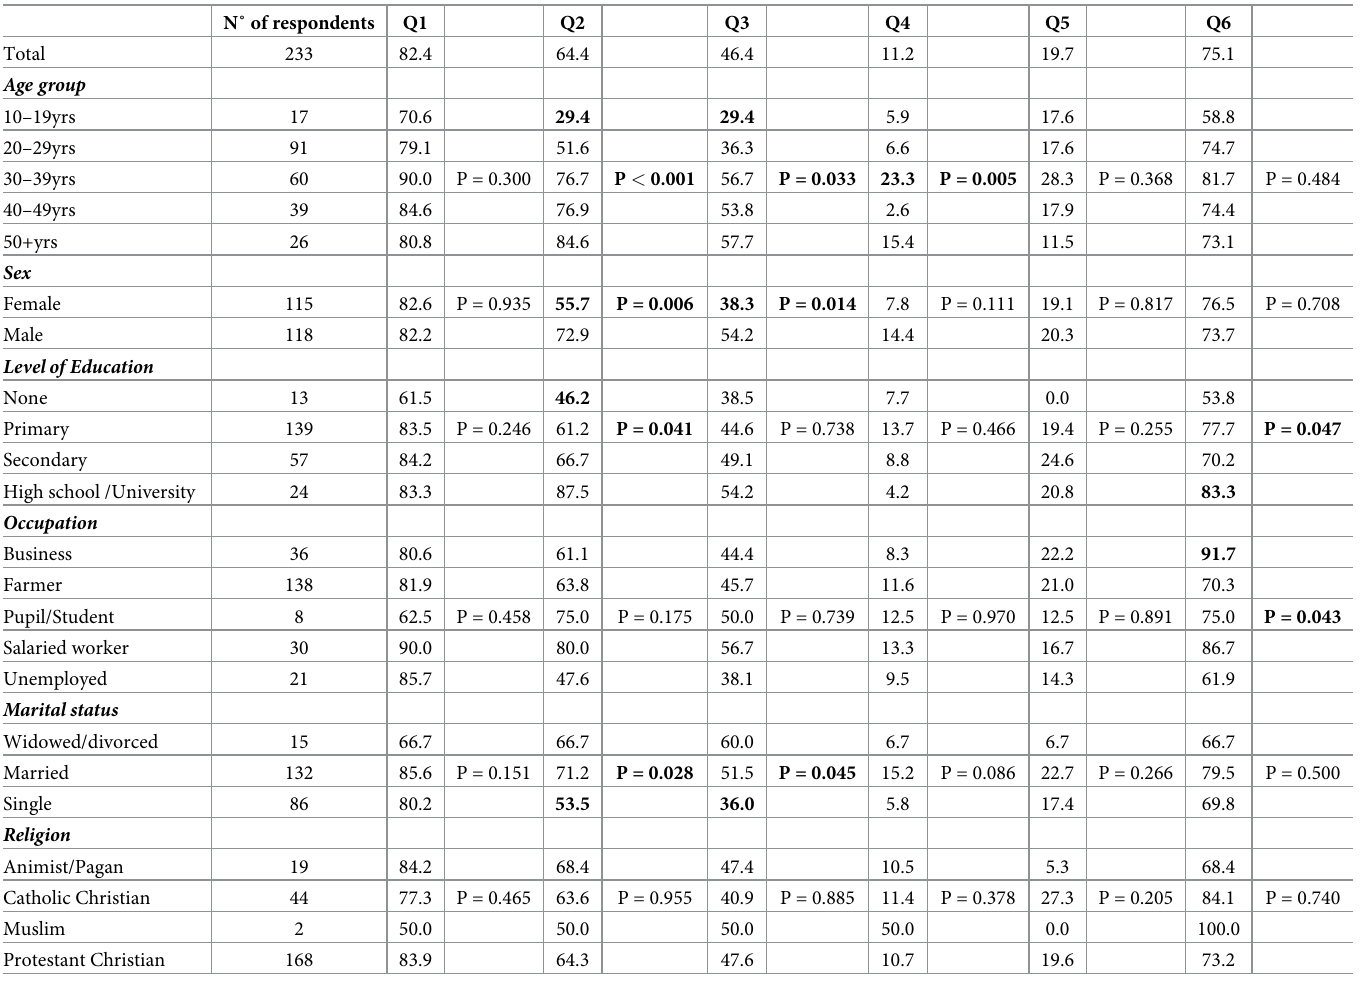
Table 2. Relationship between knowledge, beliefs and perceptions regarding leprosy and demographic